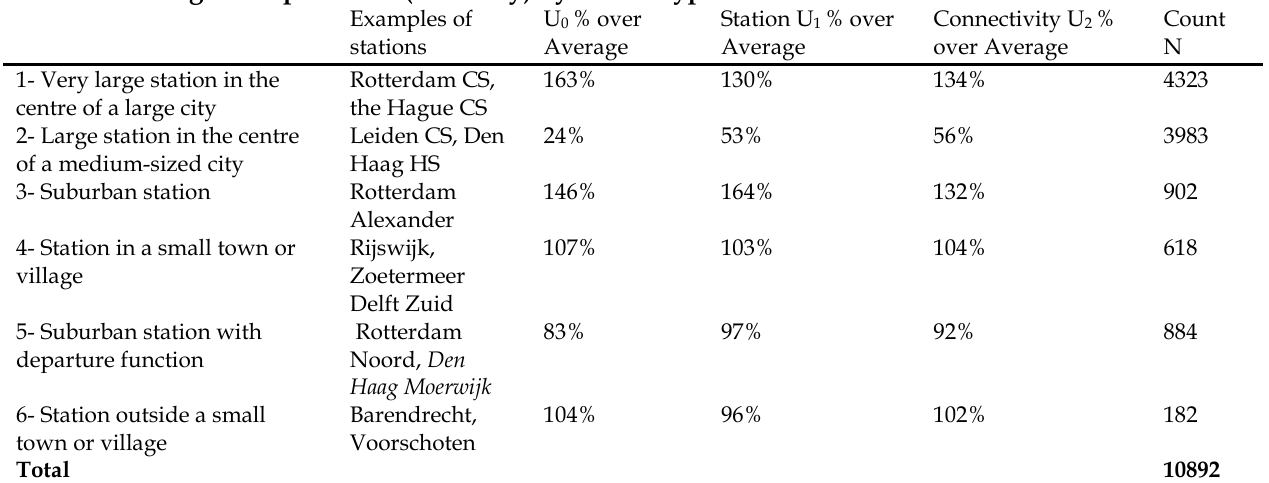
Table 2. Average transport costs (disutility) by station